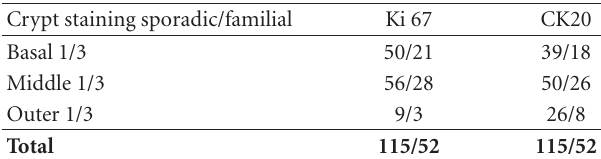
Table 7: IHC of hyperplastic